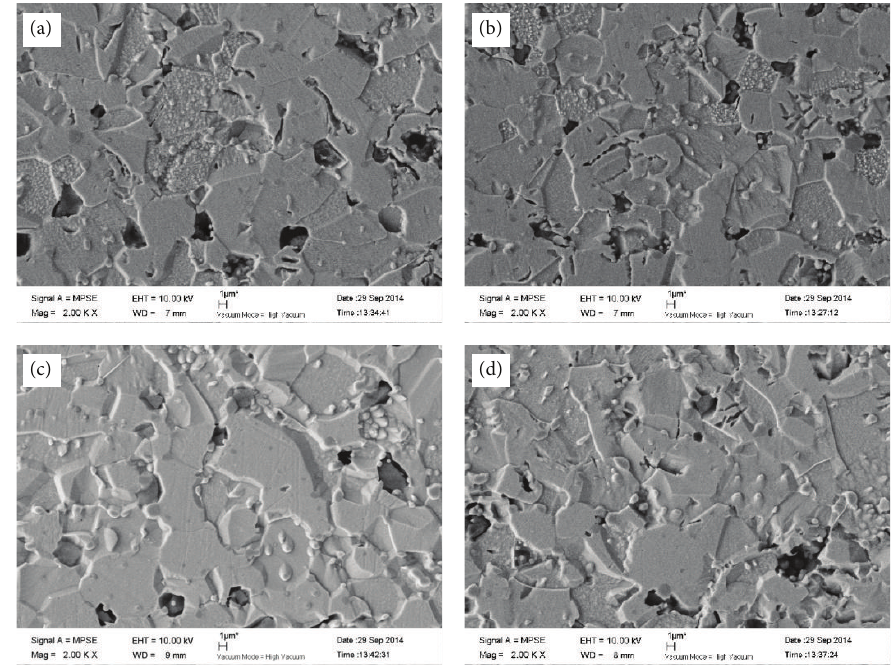
Figure 7: Microstructures of AZO targets sintered at different microwave starting temperatures: (a) 1000, (b) 1100, (c) 1200, and (d) 1300 ∘ C.